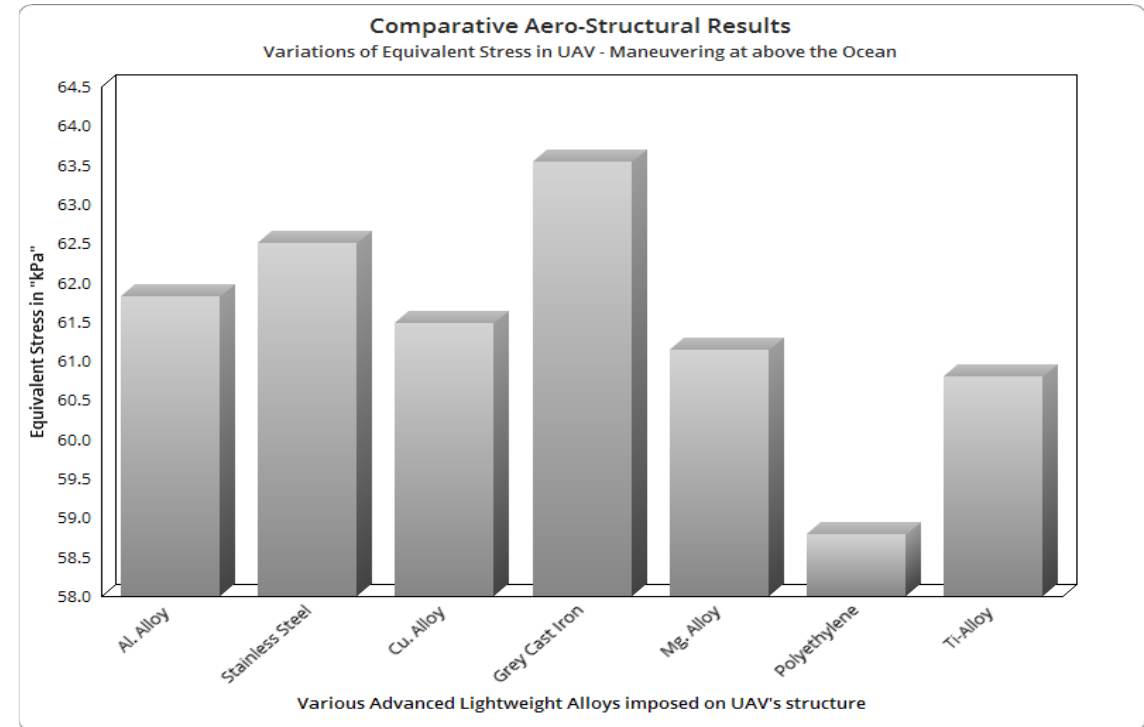
Figure 18. Comparative Equivalent Stress Variations for various alloys.